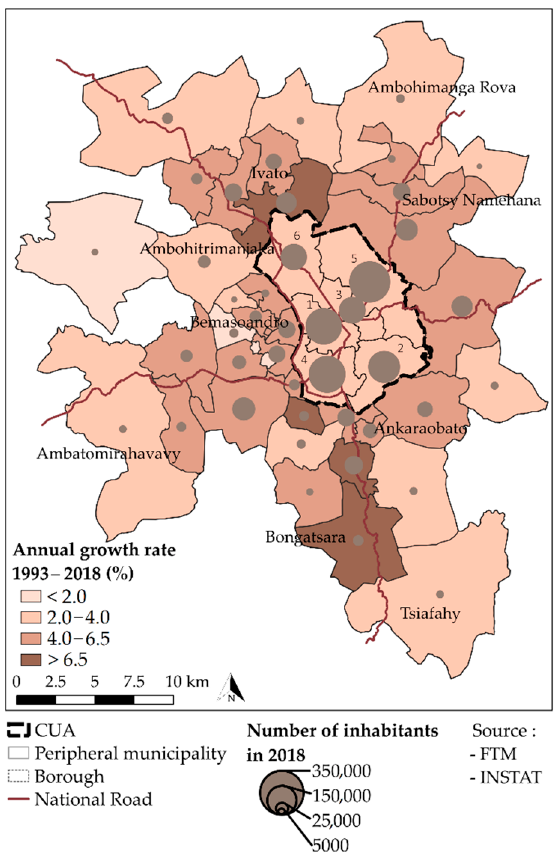
Figure 6. Annual growth rate between 1993 and 2018 and population in 2018 by borough in the CUA and by commune in the outskirts.